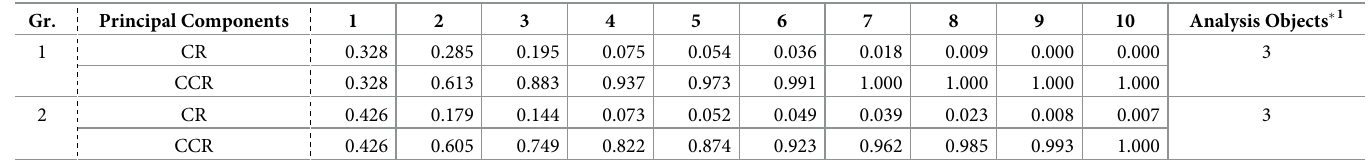
Table 5. Contribution of internet of things to the principal component analysis of connections between research fields (2018). Gr.